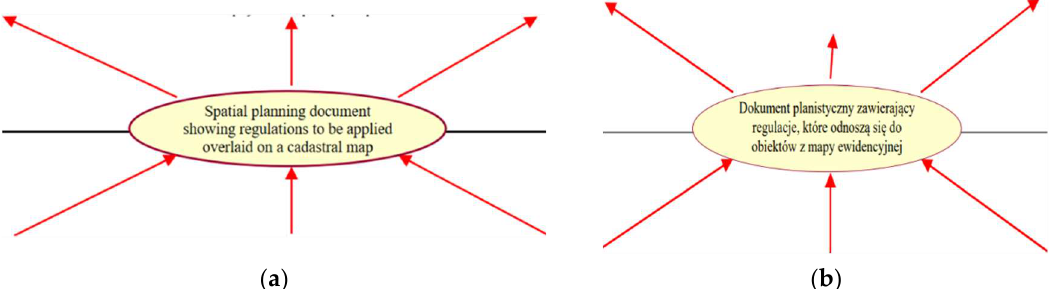
Figure 14. ( a ) English version. The faithful translation in Polish should be: ‘A spatial planning document showing the applicable regulations imposed on the cadastral map’. ( b ) Polish version: A planning document containing regulations, which relate to the objects of the ‘Registry map’ (in Poland, it is the ‘Land and Building Registry’, not a cadastral map).